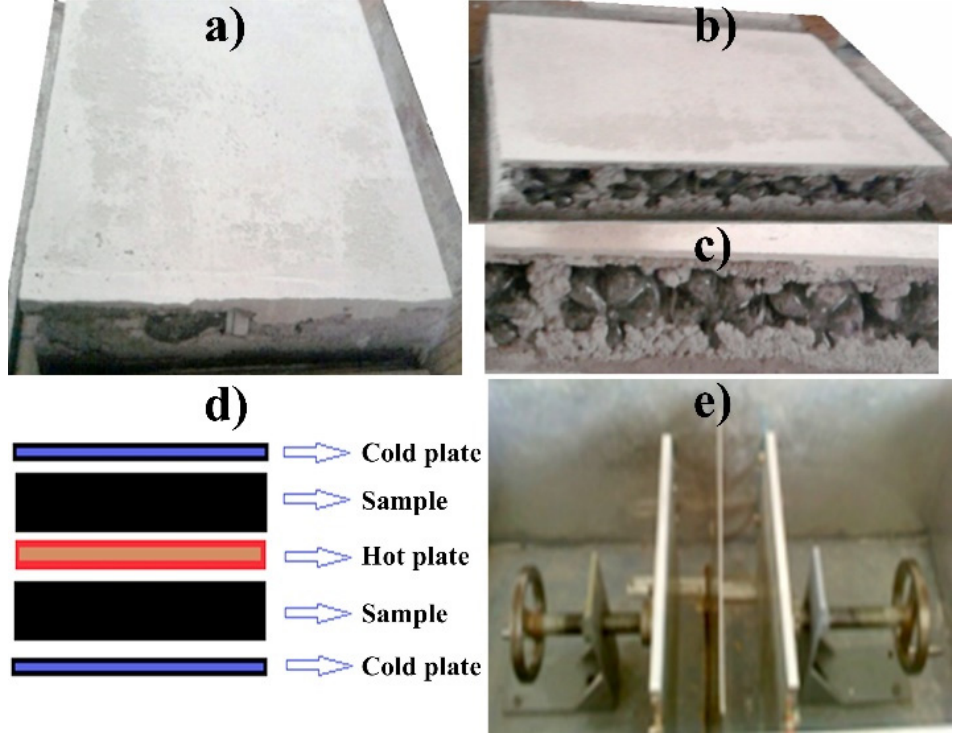
Figure 3. Blocks with bottles: ( a ) Right-side view; ( b ) left-side view; ( c ) stacking view of PET bottles; ( d ) hot plate drawer diagram; ( e ) opened drawer of hot plates. ( d ) hot plate drawer diagram; ( e ) opened drawer of hot